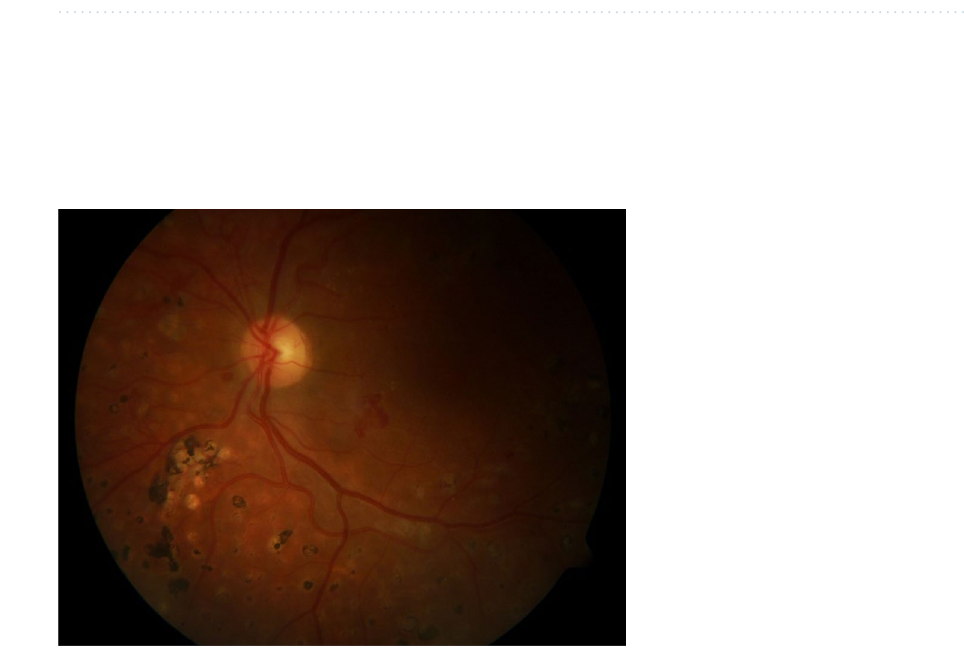
Figure 2. Sample heatmaps for ( a ) Inception, ( b ) ResNet, ( c ) InceptionResNet, ( d ) Xception.